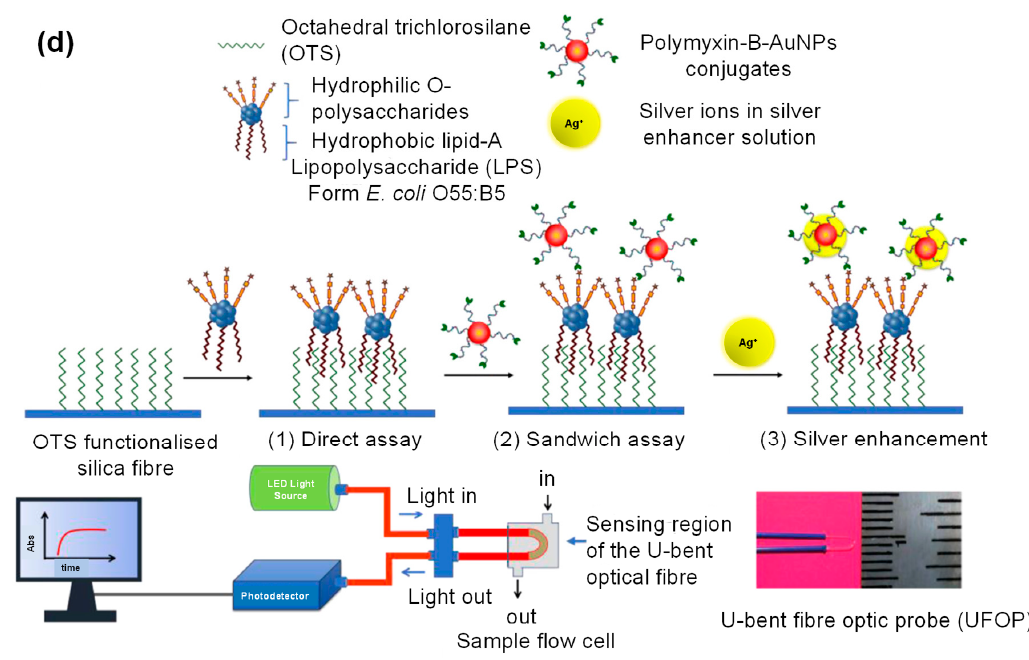
Figure 8. ( a ) Competitive binding assay for the detection of xenoestrogens [165]; ( b ) AFM 1 recognition with an optofluidic platform [167]; ( c ) HIgG sandwich assay using a U-bent fibre probe [170]; ( d ) Bacterial endotoxin recognition and signal enhancement in a U-bent fibre optic probe [171].